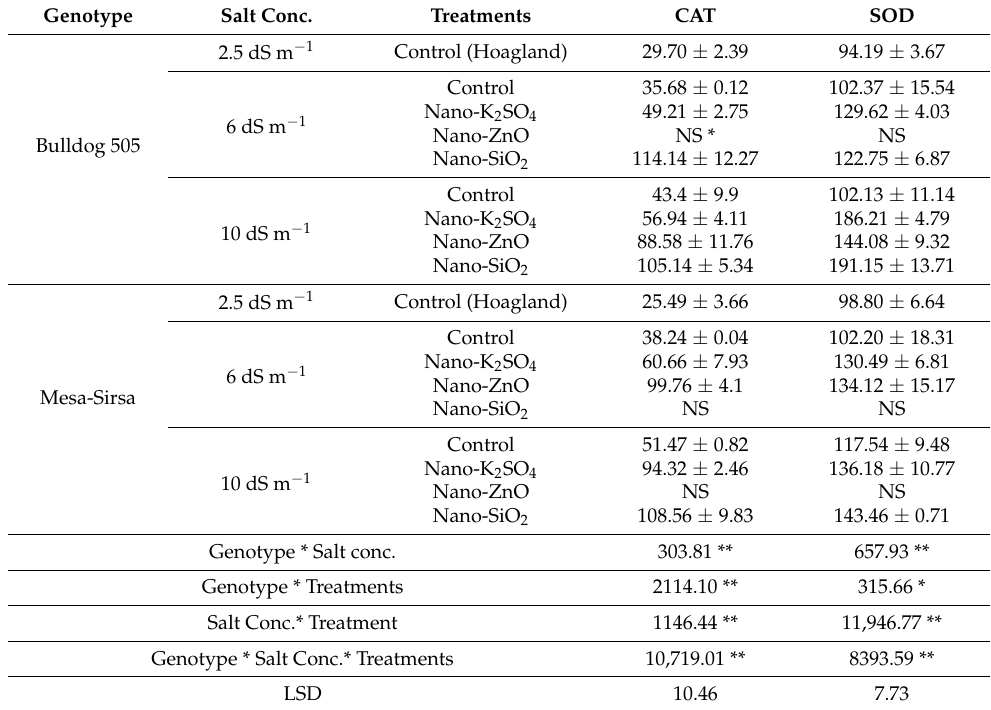
Table 3. Effect of different nano-fertilizers (K 2 SO 4 , ZnO, and SiO 2 ) on catalase (mmol H 2 O 2 min − 1 g − 1 FW) and SOD (Super oxide dismutase in U. g − 1 FW) of Alfalfa genotypes grown under three salt levels (control “Hoagland”, 10 and 15 dSm − 1 electrical conductivity). Genotype Salt